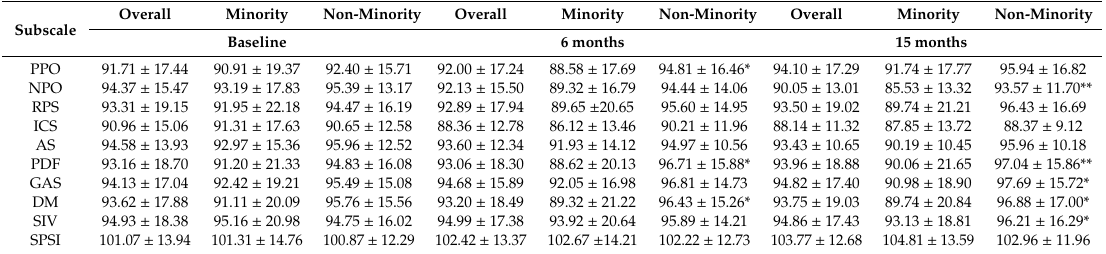
Table 3. Mean Scores for Social Problem-Solving Skills Inventory: Overall Sample vs. Minority vs. non-Minority Caregiver